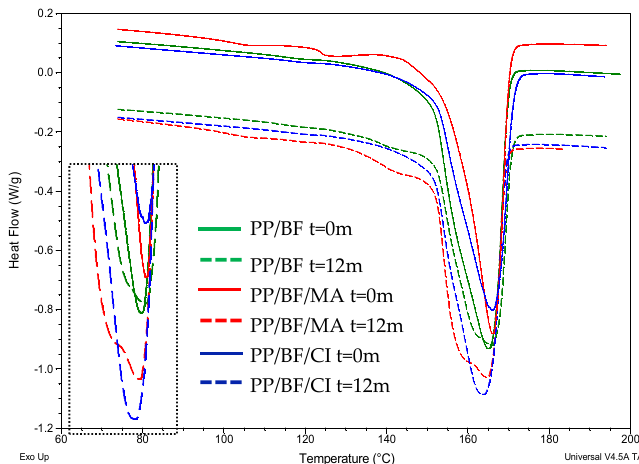
Figure 5. Di ff erential scanning calorimetry (DSC) curves of the composites before and after 12 months of exposure.